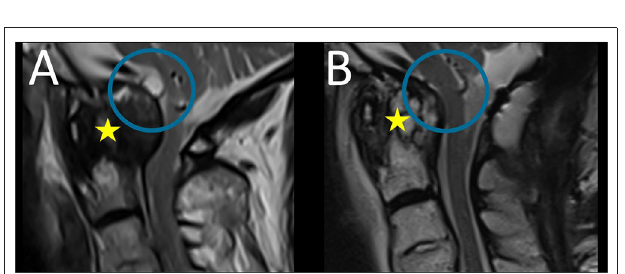
FIGURE 4 | Preoperative (A) and follow-up (B) sagittal T2-weigthed magnetic resonance images: follow-up MRI scan revealed regression of the pannus (yellow star) and the cyst with replacement of the brainstem (blue